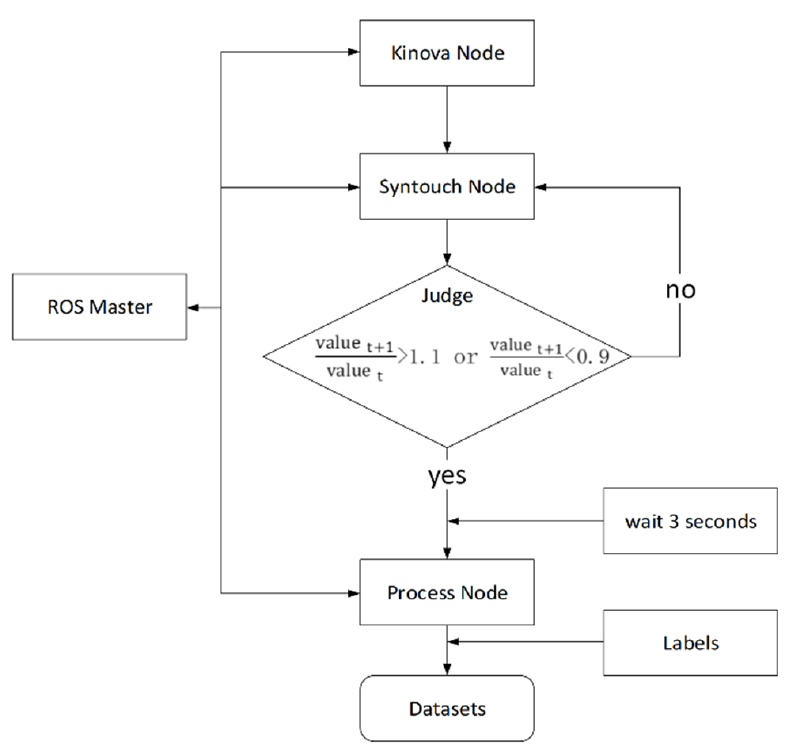
Figure 2. ROS graph of the data acquisition platform.